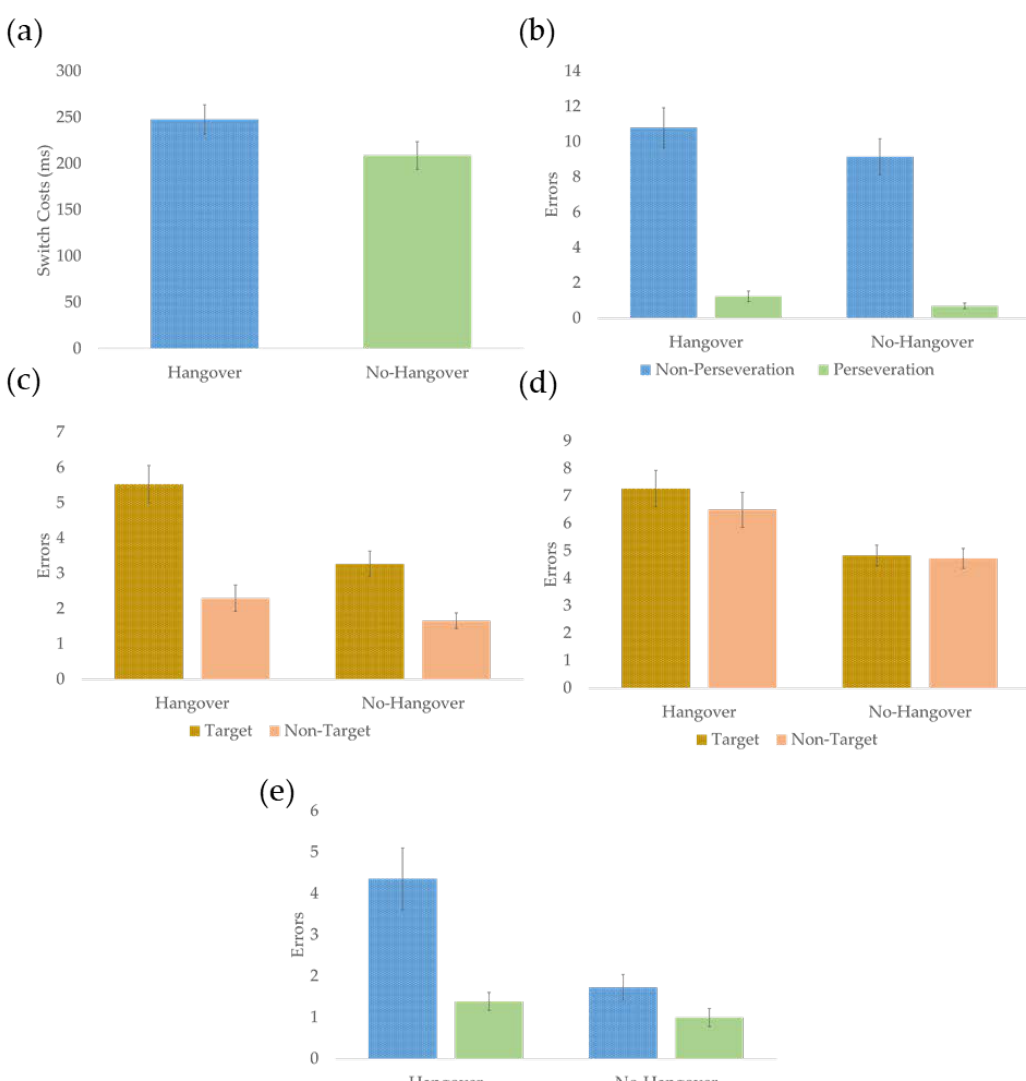
Figure 3. Graphical representations of the main effects from the three cognitive tasks. ( a ) Relative to the no-hangover condition, mean switch costs on the switching task tended to be greater when individuals were experiencing a hangover. ( b ) Relative to the no-hangover condition, mean errors on the switching task were higher when individuals were experiencing a hangover. ( c ) Relative to the no-hangover condition, errors for non-target and target stimuli in the 1-back version of the n-back task were greater in the hangover condition. ( d ) Relative to the no-hangover condition, errors in the 2-back task were greater overall in the hangover condition. ( e ) Relative to the no-hangover condition, errors on AX trials of the AX-CPT task were greater in the hangover condition. The error bars represent ± 1 standard error of the mean.